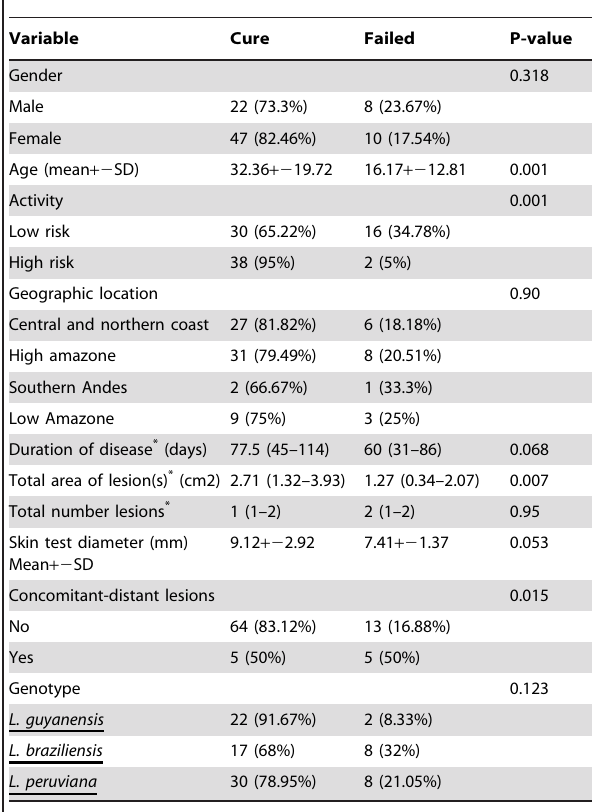
Table 1. Epidemiologial, clinical and laboratory characteristics of patients with ulcerative cutaneous leishmaniasis stratified by cure or failure condition with pentavalent antimonial treatment in